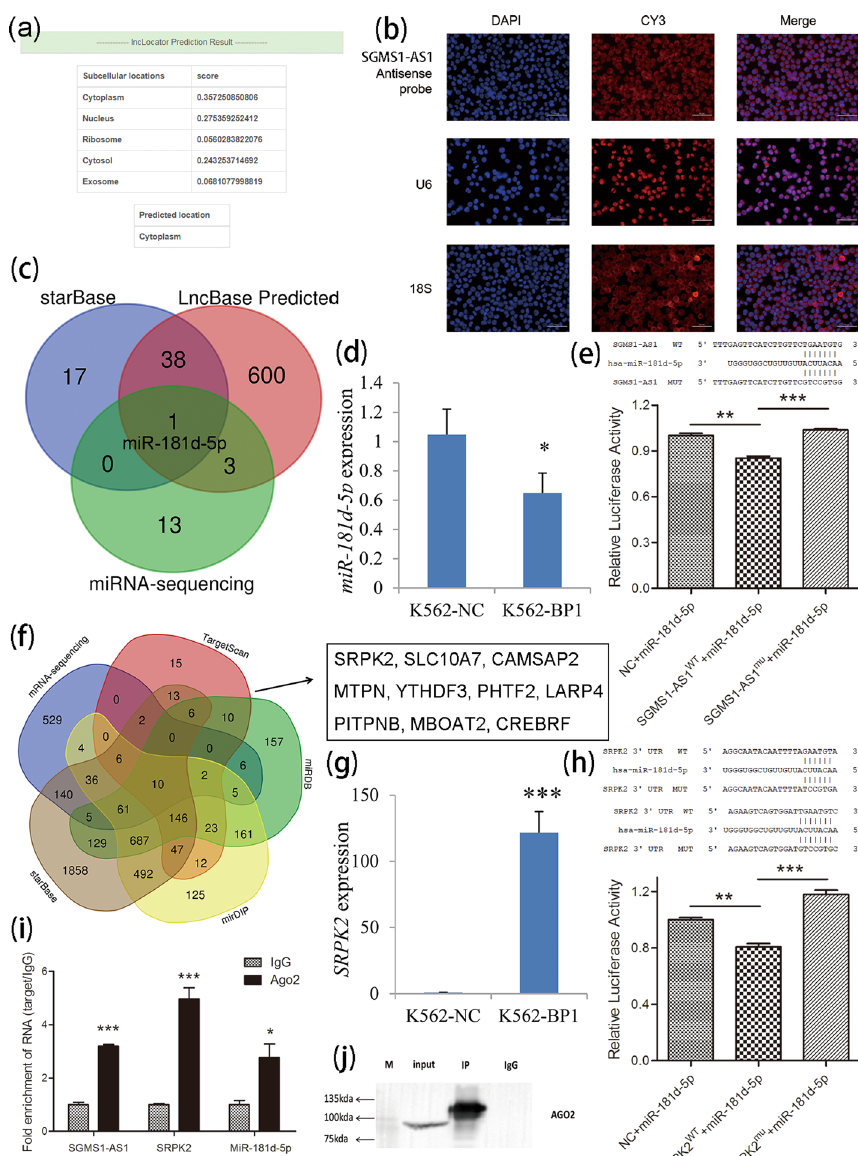
Fig. 4 Identification of the SGMS1-AS1 / miR-181d-5p / SRPK2 ceRNA network activated by BP1 overexpression. a Prediction of the location of SGMS1-AS1 by IncLocator (http:// www. csbio. sjtu. edu. cn/ bioinf/ lncLo cator). b Validation of the location of SGMS1-AS1 by RNA FISH. SGMS1-AS1 was localized mainly in the cytoplasm of K562 cells. c Prediction of the downstream miRNA of SGMS1-AS1 by Venn analysis of LncBase Predicted (http:// carol ina. imis. athena‑ innov ation. gr/ diana_ tools/ web/ index. php?r lncba sev2% 2Find ex), starBase = (http:// starb ase. sysu. edu. cn/), and miRNA‑Seq. d Validation of the selected gene expression by RT‑qPCR. e Dual luciferase experiment of SGMS1-AS1 binding to miR-181d-5p . Overexpression of miR-181d-5p significantly reduced the luciferase activity of the wild‑type SGMS1-AS1 vector but not of the mutated SGMS1-AS1 vector. f Prediction of the downstream mRNA of SGMS1-AS1 by Venn analysis of mRNA‑Seq, miRDB (http:// mirdb. org/ miRDB/), TargetScan (http:// www. targe tscan. org/ vert_ 72/), mirDIP (http:// ophid. utoro nto. ca/ mirDIP/ index. jsp), and starBase (http:// starb ase. sysu. edu. cn/). g Validation of the selected gene expression by RT‑qPCR. h Dual luciferase experiment of miR-181d-5p binding to SRPK2 . Overexpression of miR-181d-5p markedly reduced the luciferase activity of the wild‑type 3 ′ ‑UTR of SRPK2 vector but not of the mutated 3 ′ ‑UTR of SRPK2 vector. i The SGMS1-AS1 / miR-181d-5p / SRPK2 expression detected by RT‑qPCR after Ago2‑RIP. Endogenous SGMS1-AS1 , miR-181d-5p , and SRPK2 was preferentially enriched in Ago2‑RIPs compared with control IgG‑RIPs. j RNA immunoprecipitation (RIP) efficiency confirmation detected by western blot. * P < 0.05; ** P < 0.01; *** P <